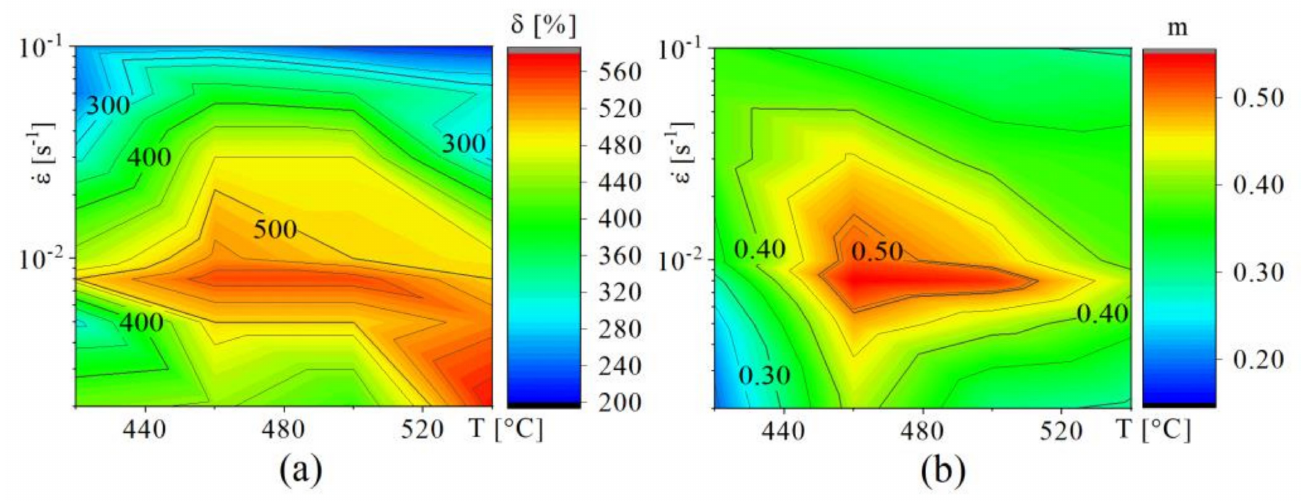
Figure 3. ( a ) Elongation to failure and ( b ) the strain-rate-sensitivity m coefficient as a function of temperature and a constant strain rate of the investigated Al-Mg-Fe-Ni-Zr-Sc